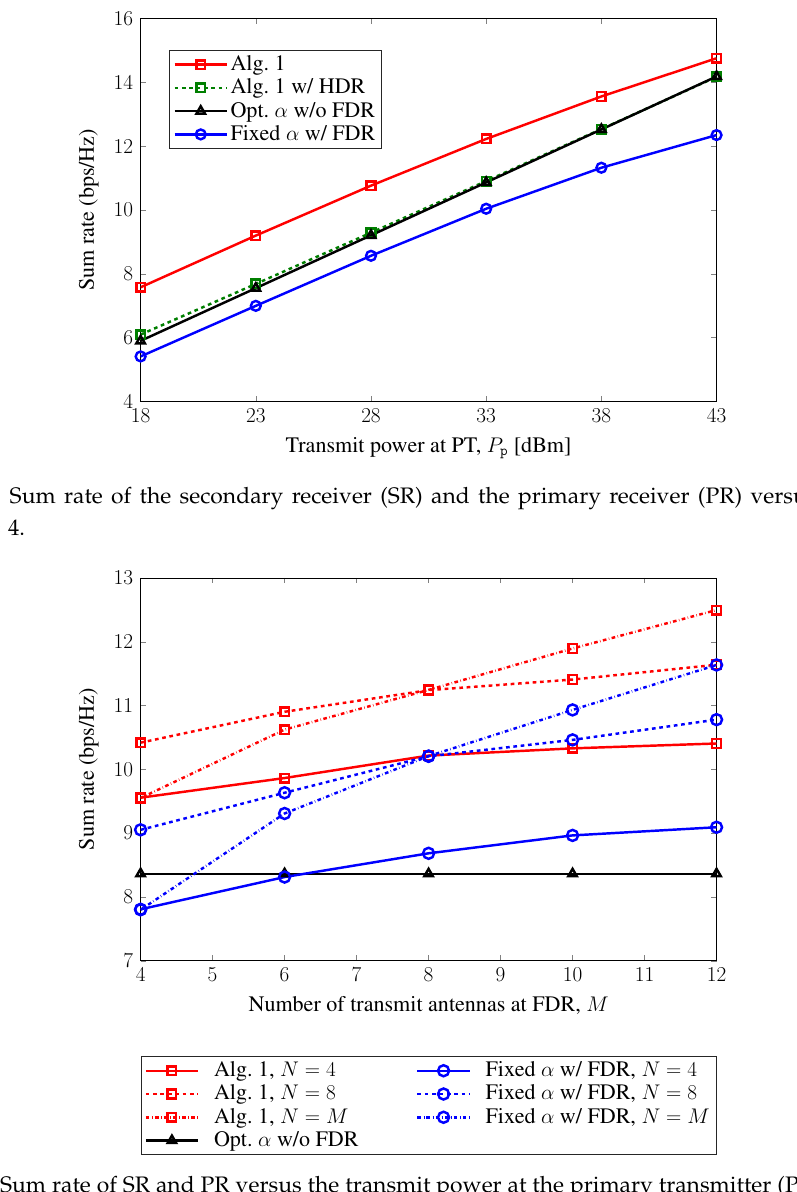
Figure 4. Sum rate of SR and PR versus the transmit power at the primary transmitter (PT) and the number of antennas at the full-duplex relay